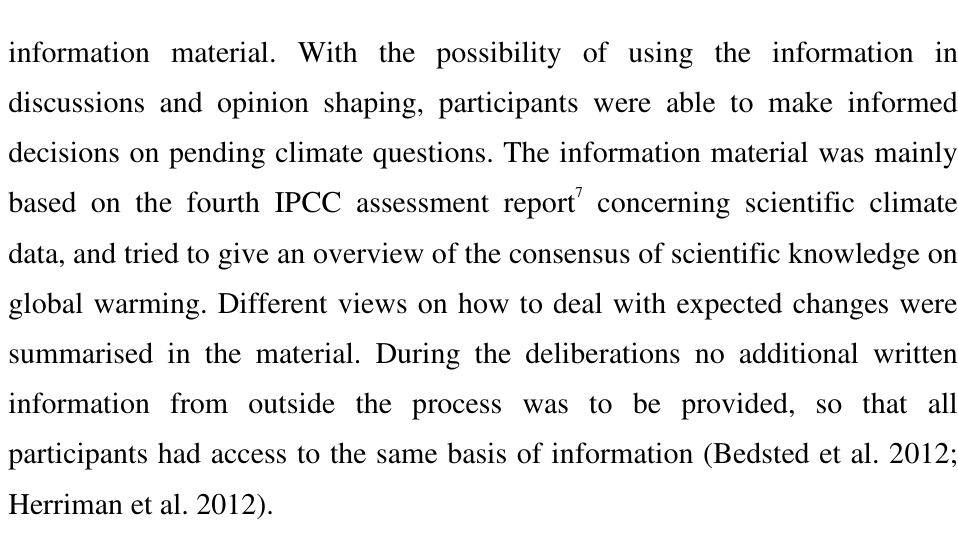
Figure 2. WWViews classified according to Fung’s democracy